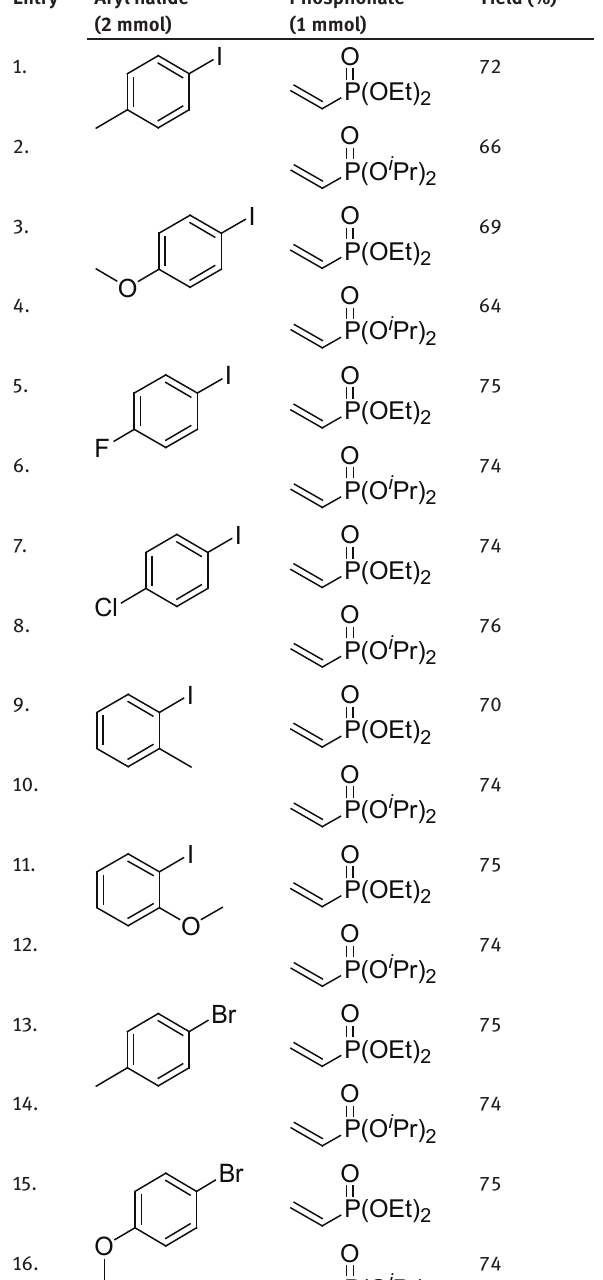
Table 4: Pd@MMT-1 clay catalyzed double Mizoroki-Heck reaction.